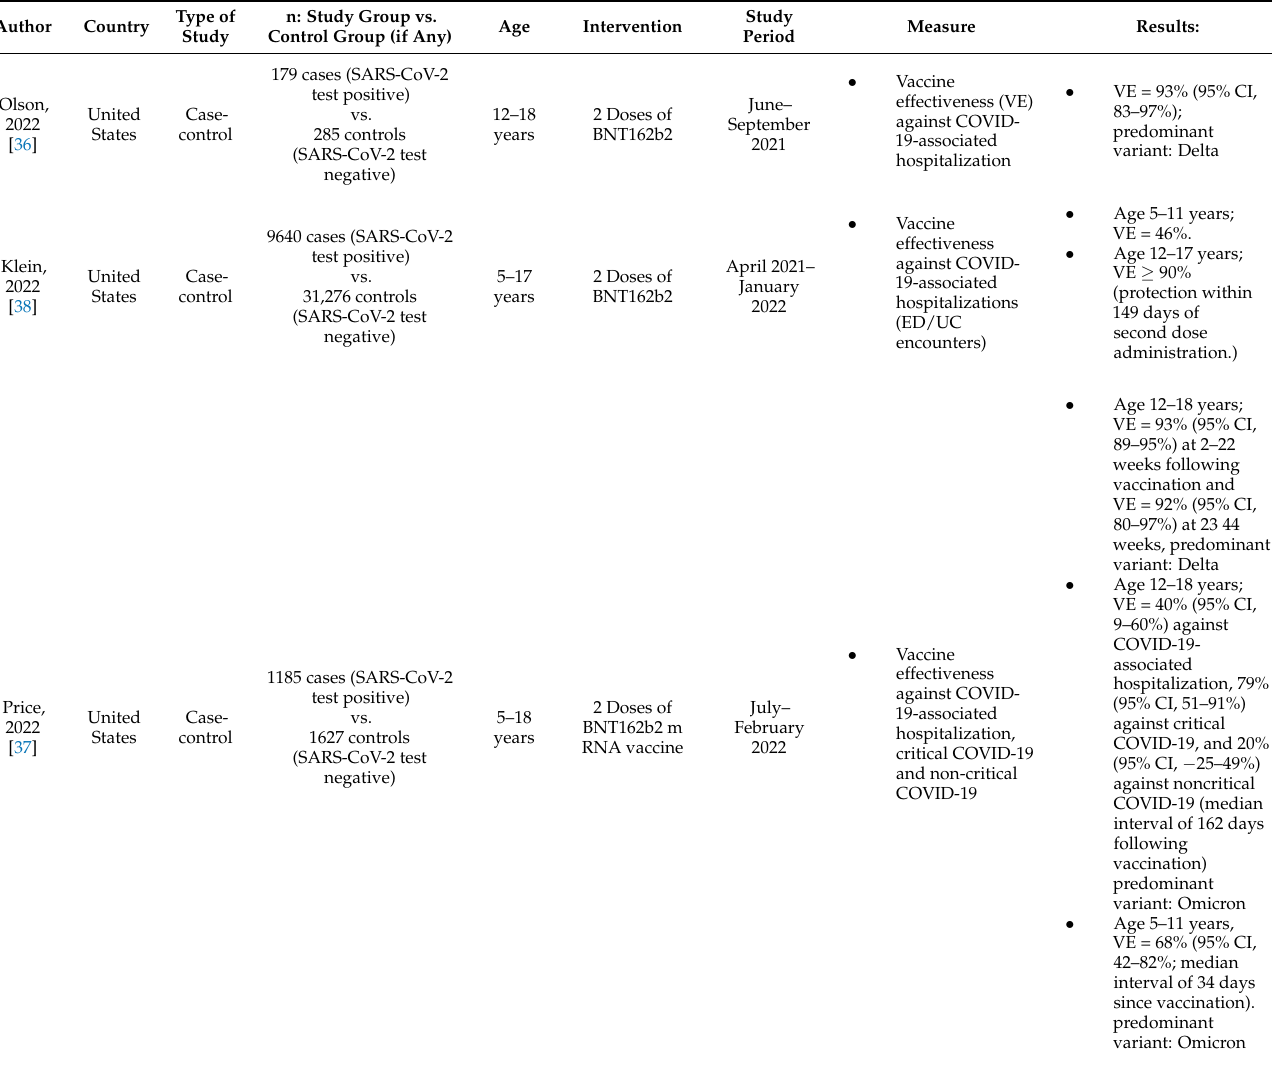
Table 2. Summary of studies showing the decrease in COVID-19-related hospitalization and MIS-C incidence in vaccinated children and infants born to mothers vaccinated during